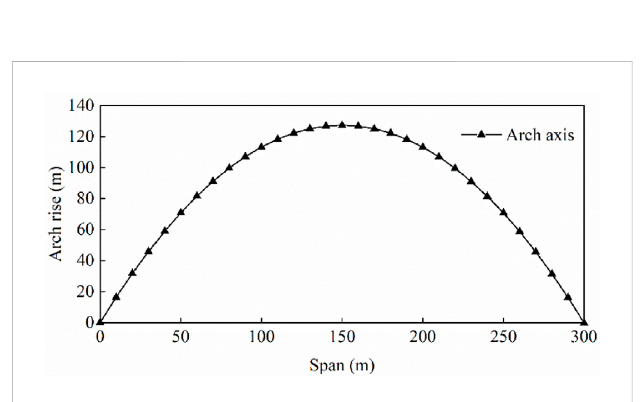
FIGURE 4 Morphological characteristic curve of SRPA (Surrounding rock pressure